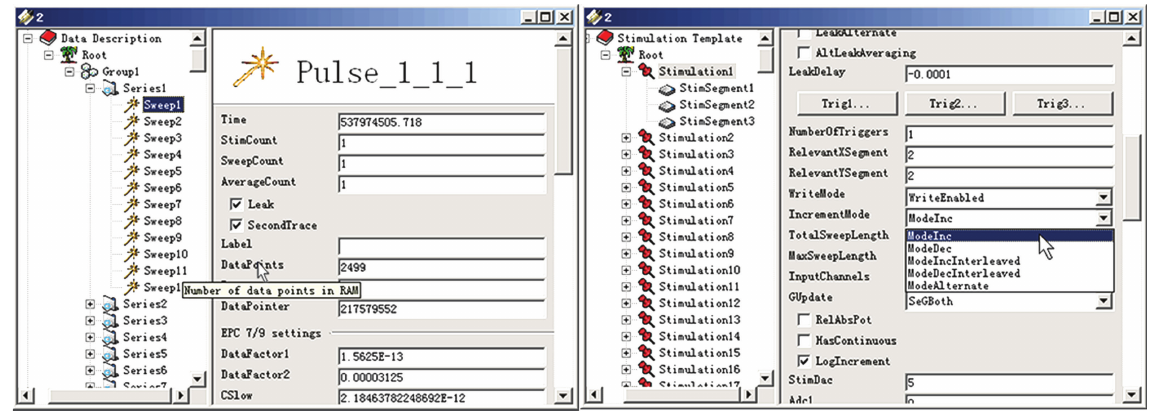
Figure 5: The parameters viewer and the parameters export dialog. PCDReader can load ∗ .pul files and ∗ .pgf files directly and display all parameter entries in an Explorer style window. The windows are shown for ∗ .pul files (left) and ∗ .pgf files (right), respectively.